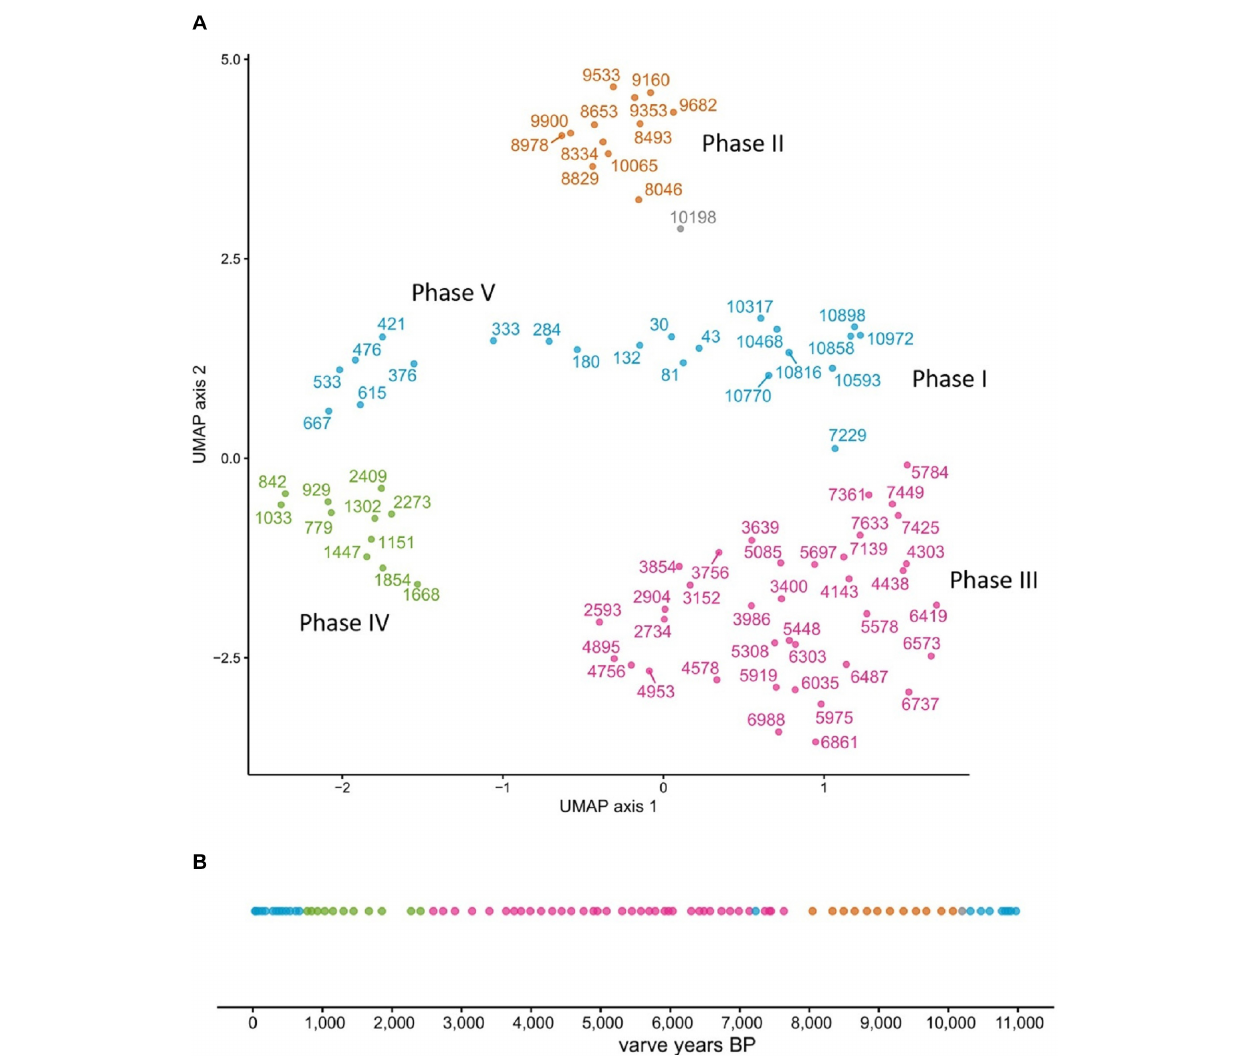
FIGURE 6 | Lake phases separation by UMAP. The core was clustered into 4 separate groupings (A) , which when resolved temporally yield five distinct lake phases (B) . Note that one data point could not be assigned to a grouping (gray